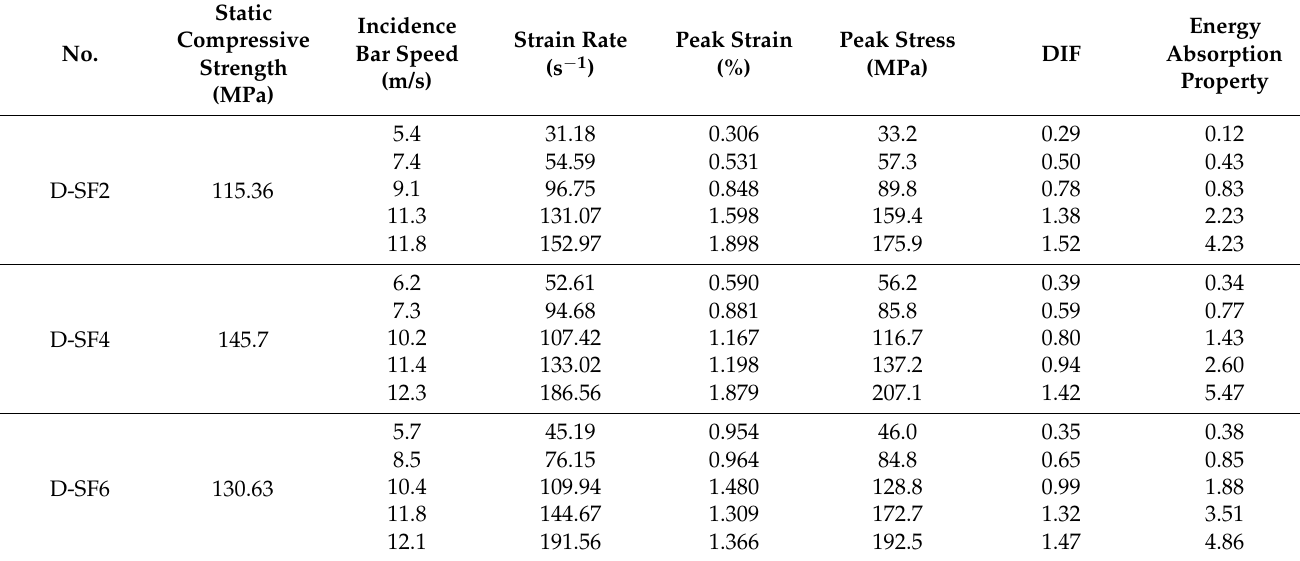
Table 4. Influence of directional fiber content on impact compression